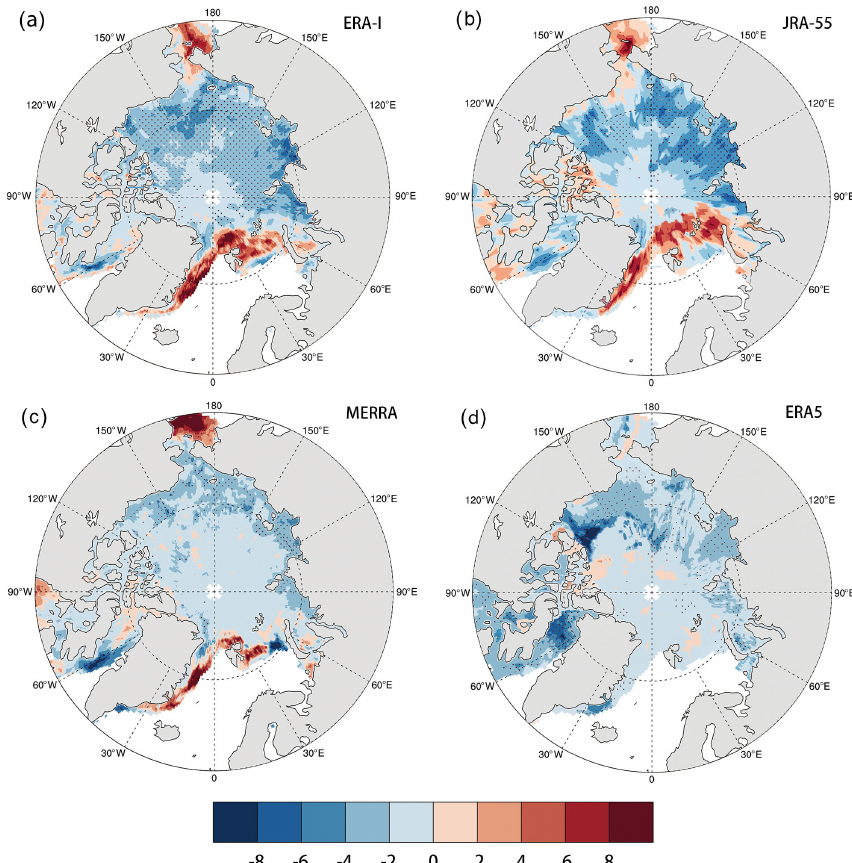
Figure 2. Trend in the date of the first rainfall in spring (March to June) over Arctic sea ice north of 50 ◦ N during 1980–2017 in (a) ERA-I, (b) JRA-55, (c) MERRA, and (d) ERA5 (units: days per decade). The trend is calculated only for grid cells which experienced rainfall between March and June in more than 80% of the years in the record (i.e., in > 30 years). Dotted regions indicate that the trends are significant at the 95% confidence level or higher ( p< 0 . 05). A negative trend means that the first rainfall shifts to earlier